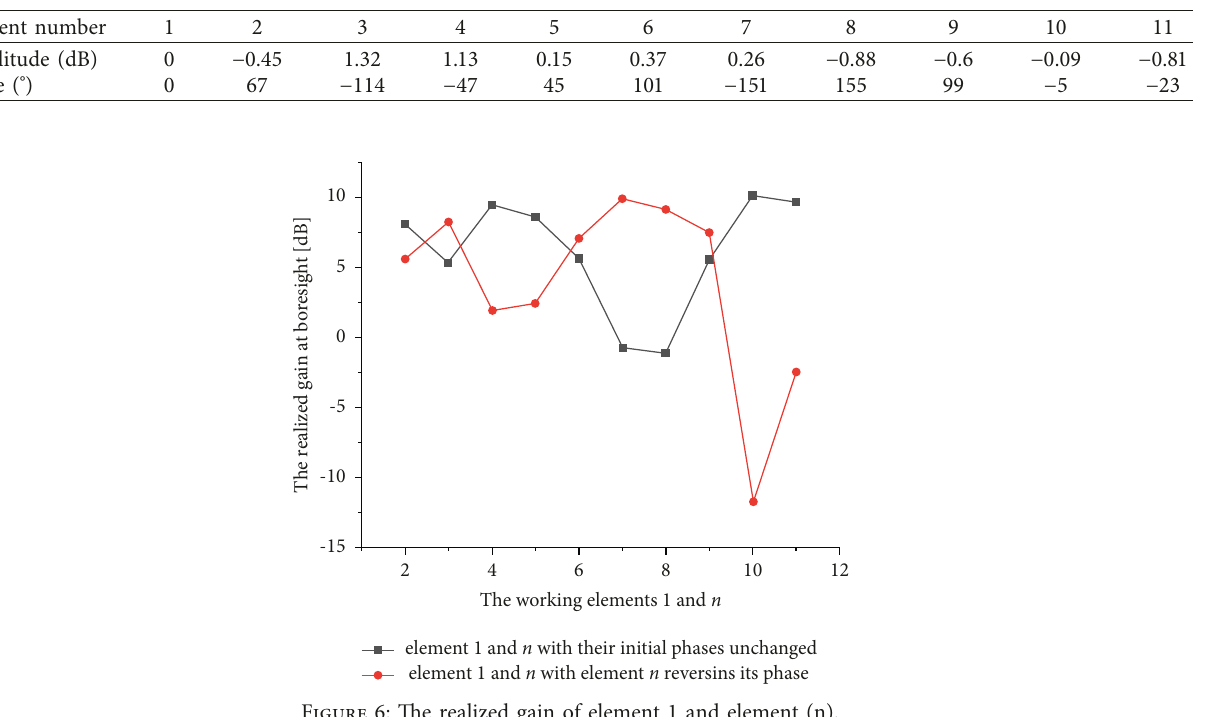
Table 2: The initial excitations of all elements.